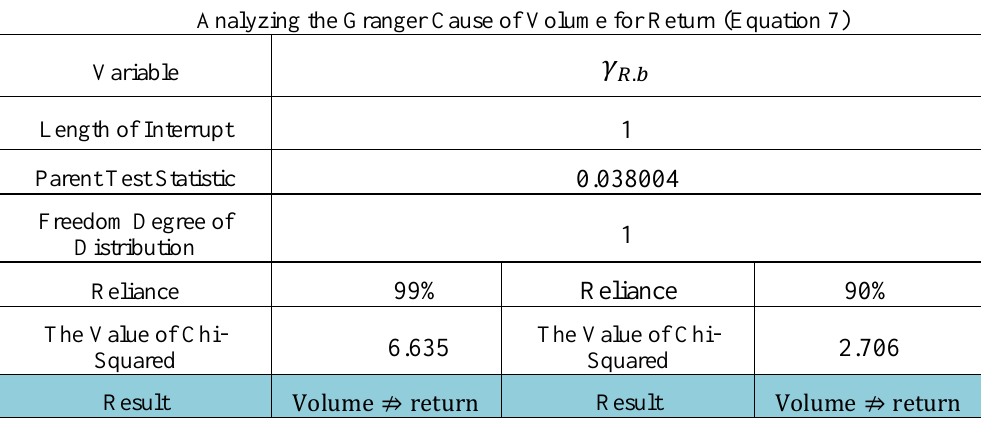
Table 1. The Estimation Results of the Conditional Mean Return Equation Analyzing the Granger Cause of Volume for Return (Equation 7)